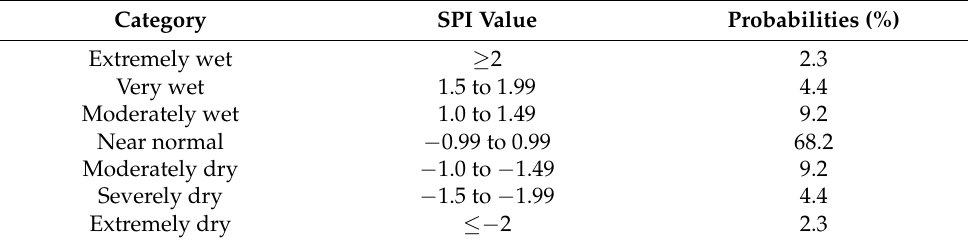
Table 1. Classification of wet and dry periods based on standardized precipitation index (SPI). Category SPI Value Probabilities